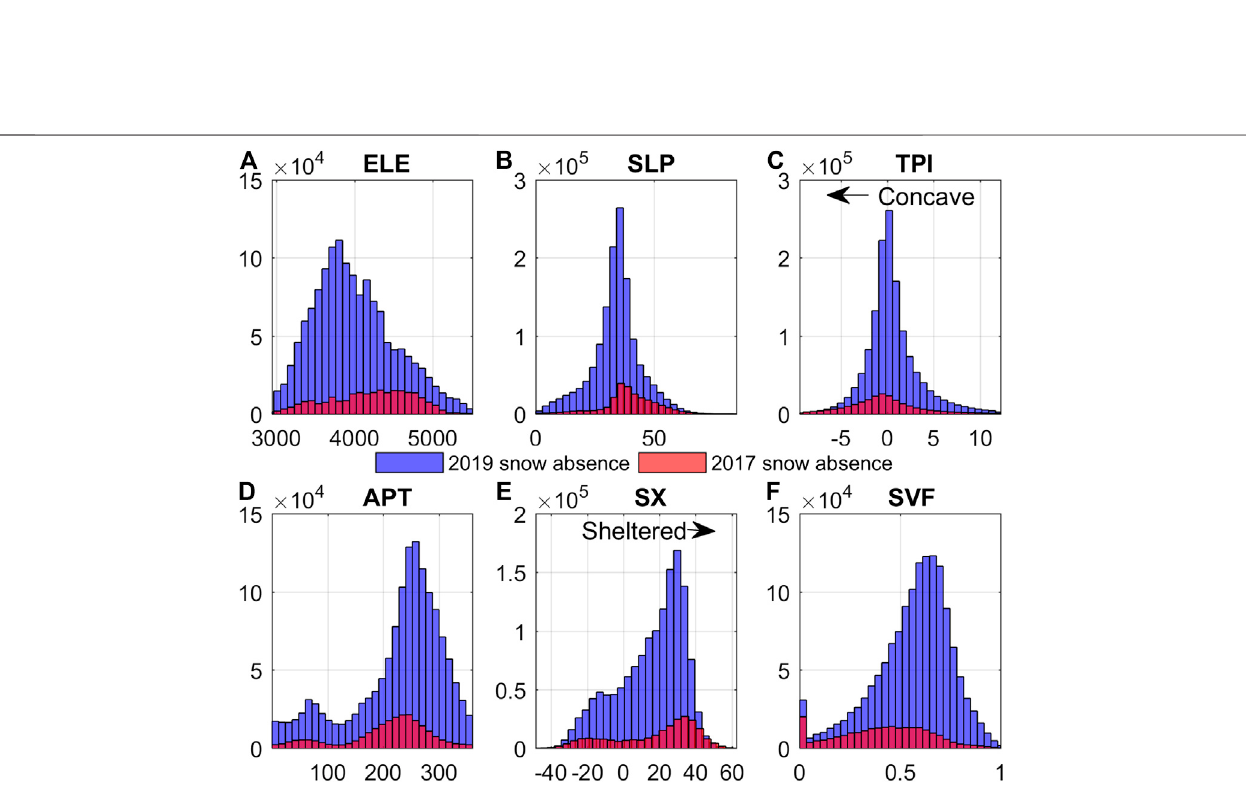
Frontiers in Earth Science |